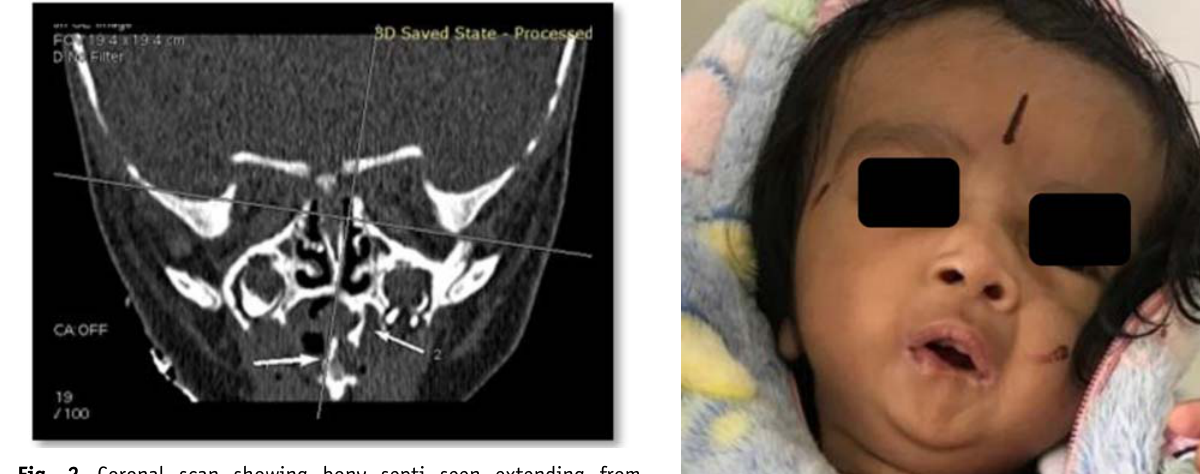
Fig. 2. Coronal scan showing bony septi seen extending from mandible to maxilla in the midline and left side.